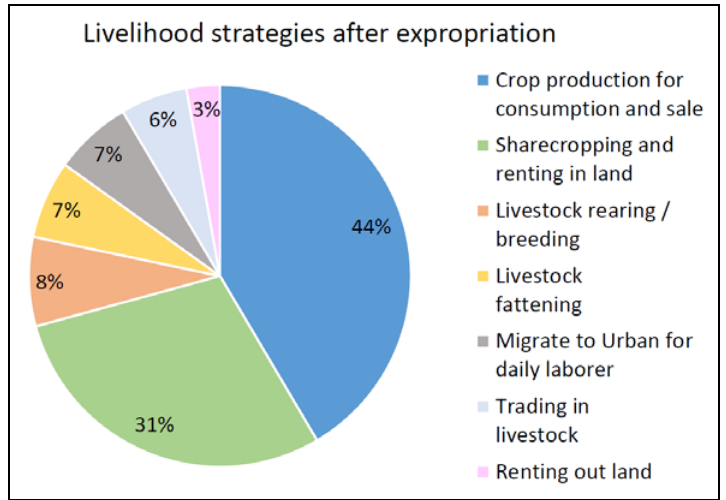
Figure 4. Respondents’ livelihood strategies after expropriation. Source: Household survey, n = 100, 2020.